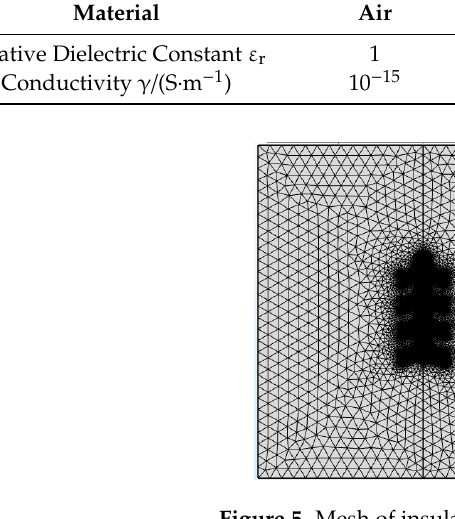
Figure 5. Mesh of insulator string model.